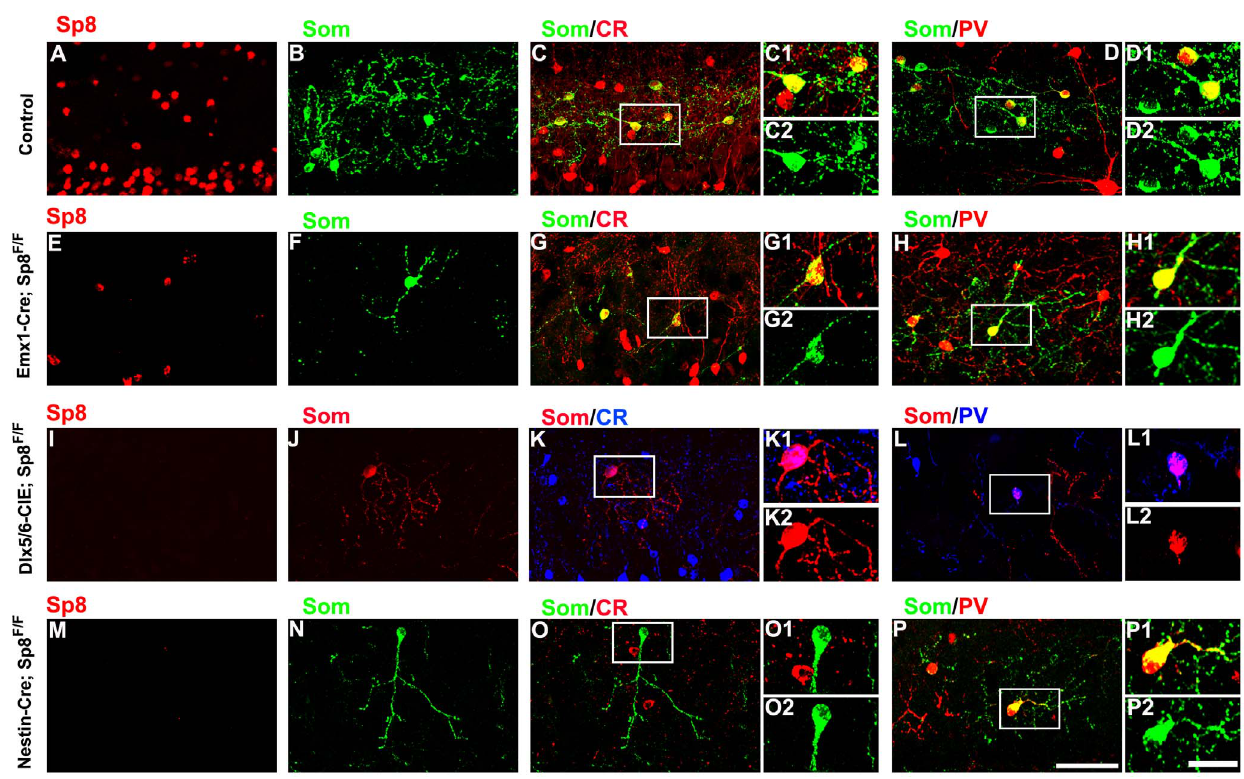
Figure 5. The density of the Som + cells in the EPL of the OB is significantly decreased in the Sp8 conditional mutant mice. (A–D) The representative images that showing the expression of Sp8 (A), Som + (B), Som + /CR + (C) and Som + /PV + (D) cells in the EPL in the OB of adult control mice. (E–H) The representative images showing the expression of Sp8 (E), Som + (F), Som + /CR + (G) and Som + /PV + (H) cells in the EPL in the OB of adult Emx1-Cre; Sp8 Flox/flox mutant mice. (I–L) The representative images that showing the expression of Sp8 (I), Som + (J), Som + /CR + (K) and Som + / PV + (L) cells in the EPL in the OB of adult Dlx5/6-CIE; Sp8 Flox/flox mutant mice. (M–P) The representative images that showing the expression of Sp8 (M), Som + (N), Som + /CR + (O) and Som + /PV + (P) cells in the EPL in the OB of adult Nestin-Cre; Sp8 Flox/flox mutant mice. Scale bars: 50 m m (bar in P applies to A–P), 20 m m (in P2 applies to C1, C2, D1, D2, G1, G2, H1, H2, K1, K2, L1, K2, O1, O2, P1 and P2).